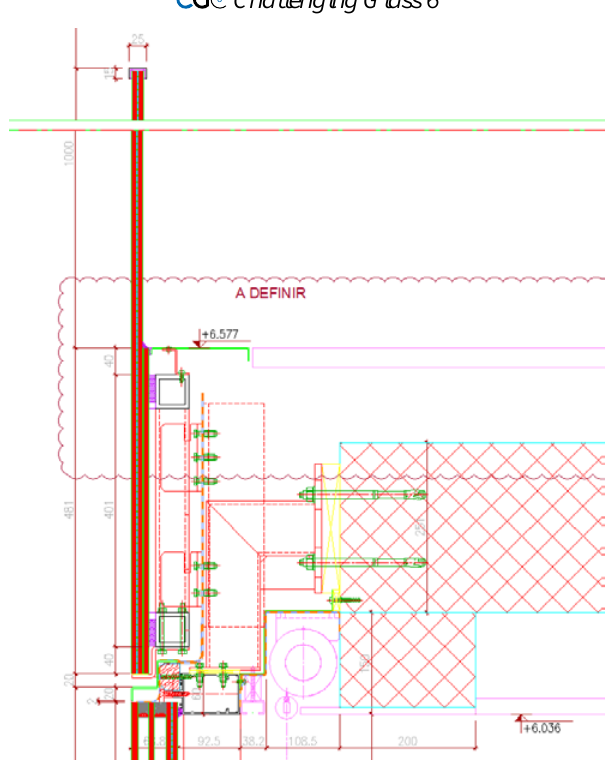
Fig. 6: Vertical section at sliding window area showing barrier detail